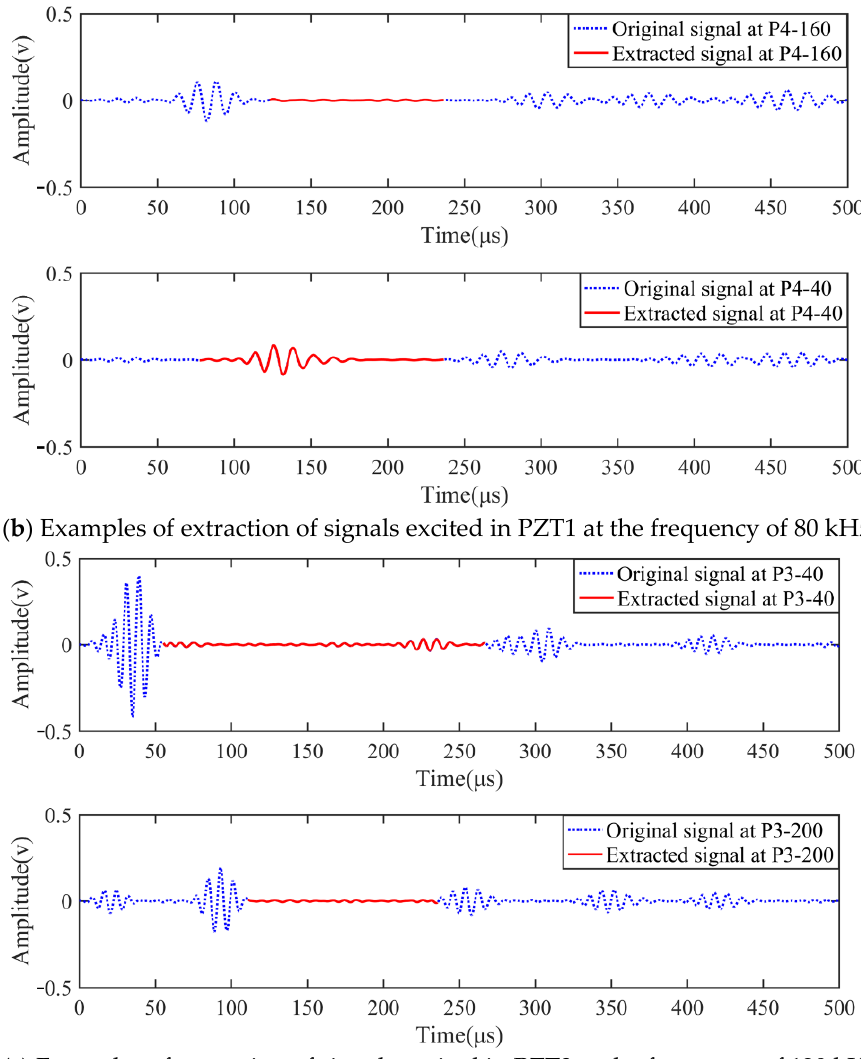
Figure 8. Examples of received and extracted signals at two different sensing points on the same path: ( a ) signals at P2-40 and P2-160; ( b ) signals at P4-40 and P4-160; ( c ) signals at P3-40 and P3-200.